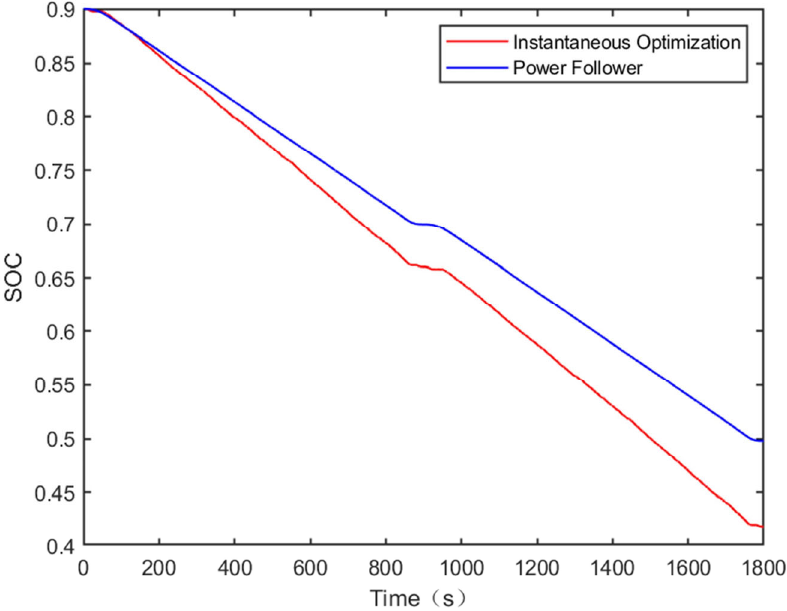
Figure 20. SOC state value changes.